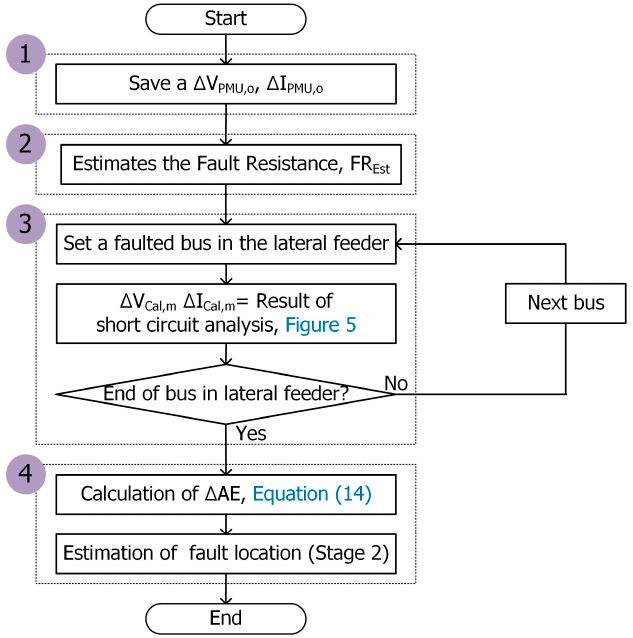
Figure 7. Flowchart of the proposed fault location method (Stage 2).